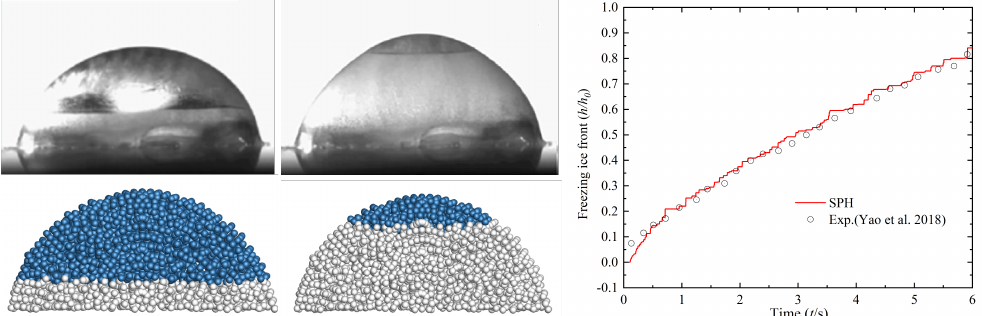
Figure 17. Comparison of SPH results and experimental snapshots [74] for the icing process of